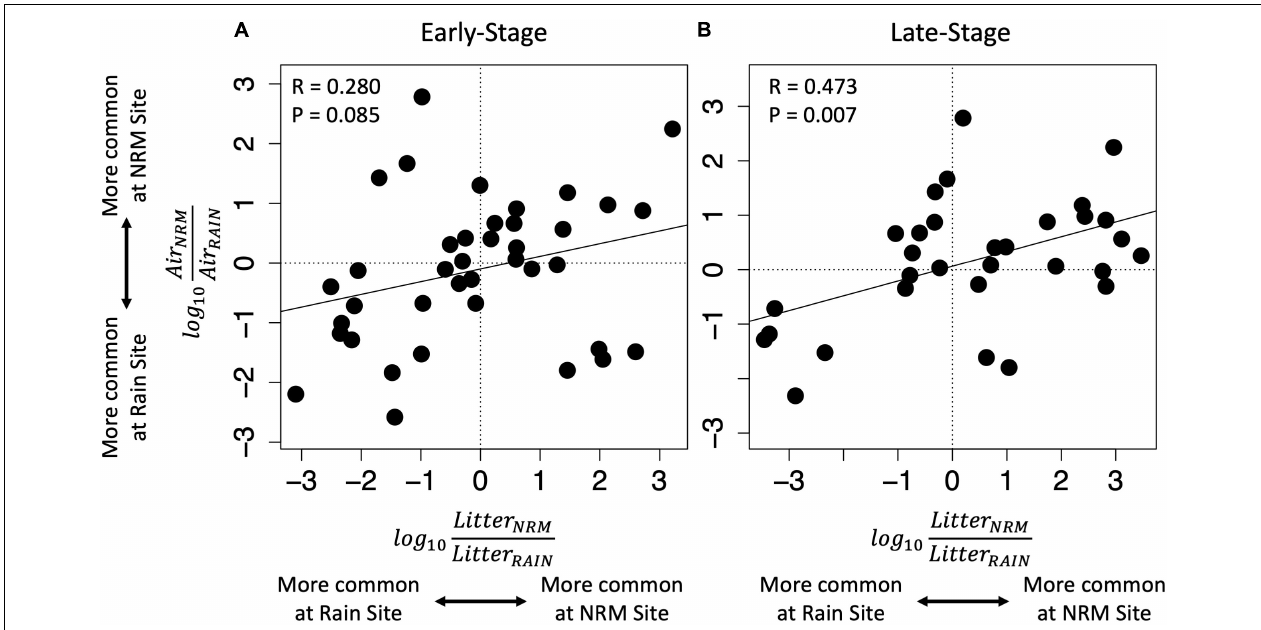
FIGURE 4 | The degree of site preference on bait tillers versus site preference on native litter for taxa with non-zero abundances at both sites. Note that taxa that are abundant on native litter at one site ( x -axis) are also more abundant on bait tillers colonized by air-derived fungi at that site ( y -axis). This pattern is stronger for late-stage (B) than for early-stage tillers (A) . Each point represents one OTU and each unit above or below zero corresponds to a 10-fold greater relative abundance at a particular site with positive values indicating a greater relative abundance at the NRM site and negative values indicating a greater relative abundance at the Rain site. Regression lines and statistics are for simple linear